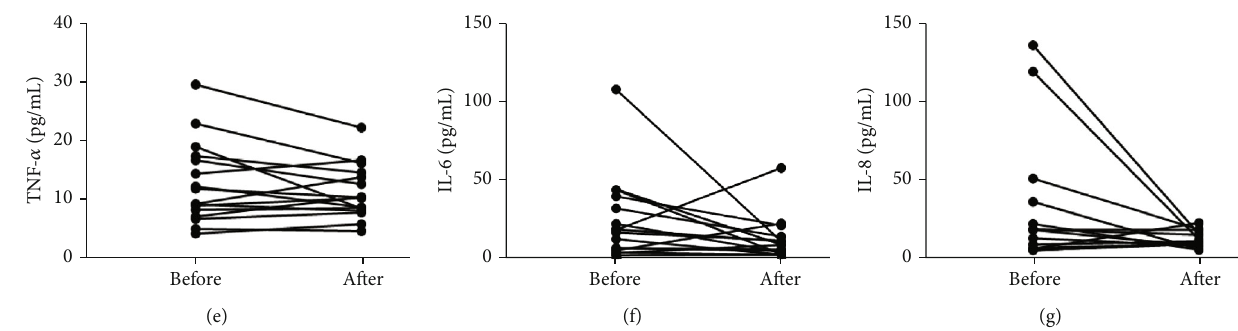
Figure 1: Uric acid is associated with serum levels of TNF- α , IL-6, and ferritin in COVID-19 patients. (a) Left, serum uric acid (UA) is associated with serum TNF- α level; right, serum TNF- α level in patients with a UA level of lower or higher than 400 μ mol/L. (b) Left, association between serum UA and IL-6 levels; right, serum IL-6 level in patients with a UA level of lower or higher than 400 μ mol/L. (c) Left, association between serum UA and ferritin levels; right, serum ferritin level in patients with a UA level of lower or higher than 400 μ mol/L. (d) Left, association between serum UA and IL-10 levels; right, serum IL-10 level in patients with a UA level of lower or higher than 400 μ mol/L. (e) Serum TNF- α level before and after uric acid lowering therapy. (f) Serum IL-6 level before and after uric acid lowering therapy. (g) Serum IL-8 level before and after uric acid lowering